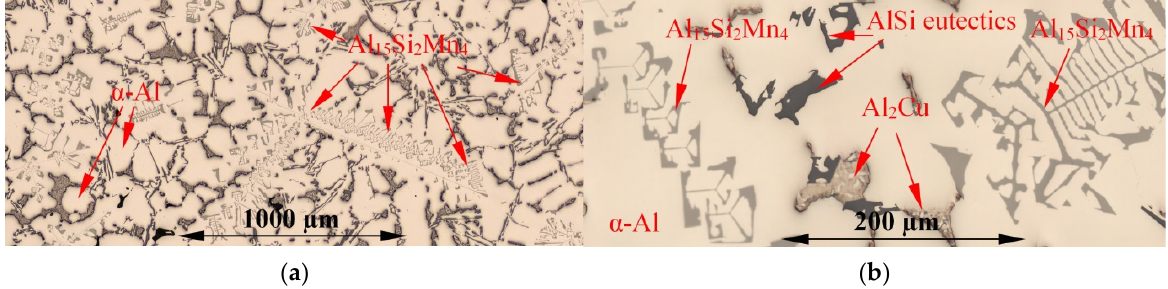
Figure 11. Microstructures of the AlCu4Si6Mn2.0 specimen solidified without electromagnetic stirring. LOM: ( a ) magni- fication 100× and ( b ) magnification 500×.